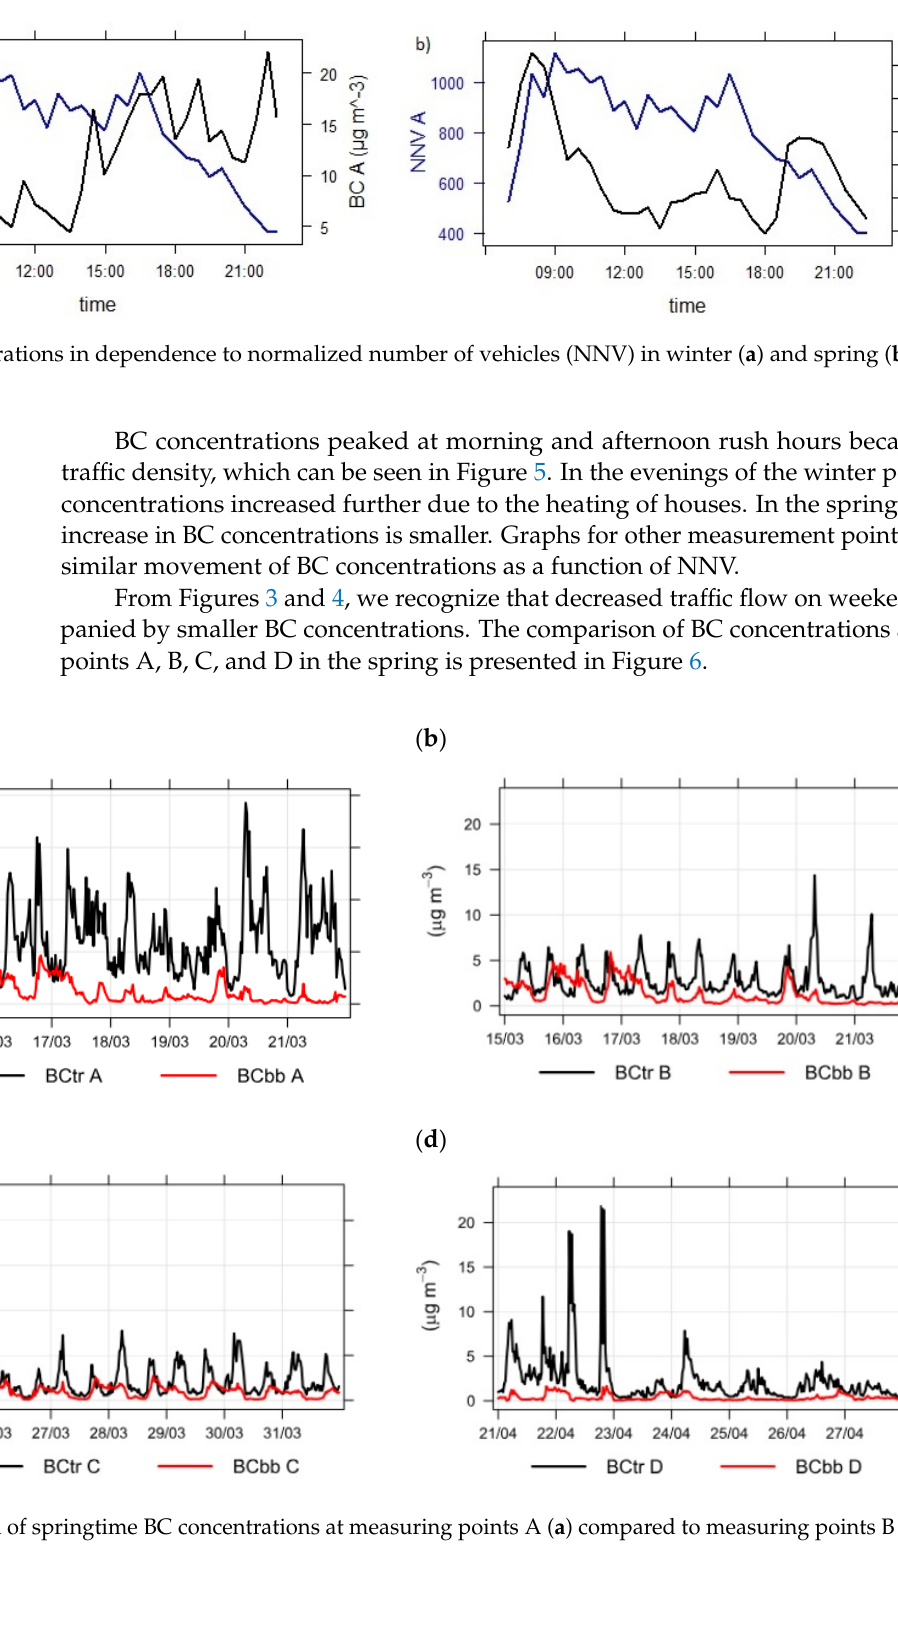
Figure 4. BC concentrations and wind values for measuring point A (graph a ), measuring point B (graph b ), and measuring point C (graph c ).